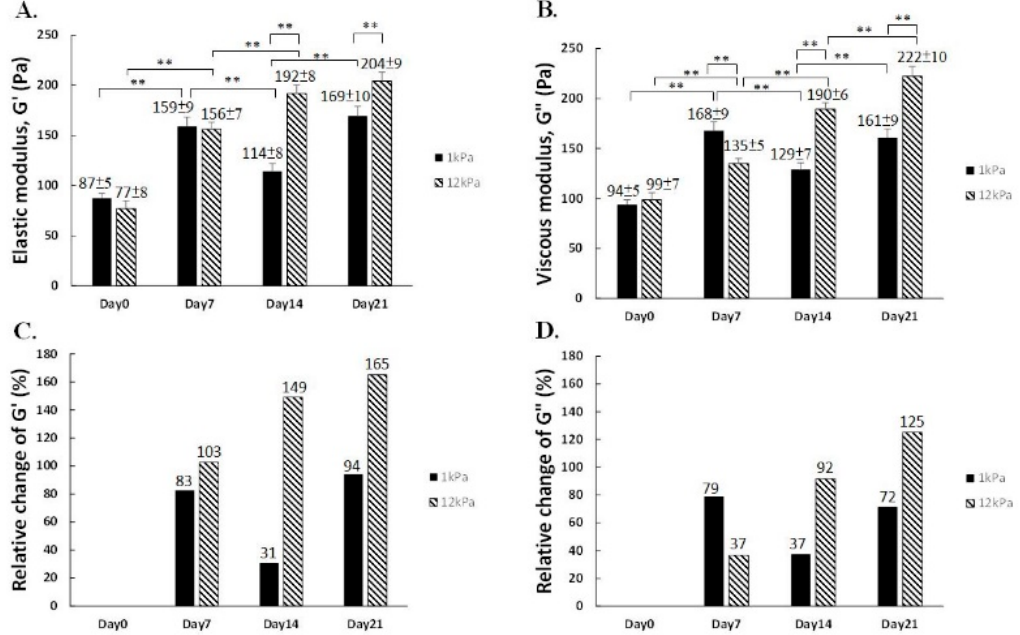
Figure 6. Viscoelasticity of hMSCs during osteogenesis. ( A , B ) The elastic (G’) and viscous modulus (G”) of hMSCs cultured in stiff and soft substrates. ( C , D ) Relative changes of Young’s modulus in the course of chemically-induced osteogenesis. (** p < 0.01)